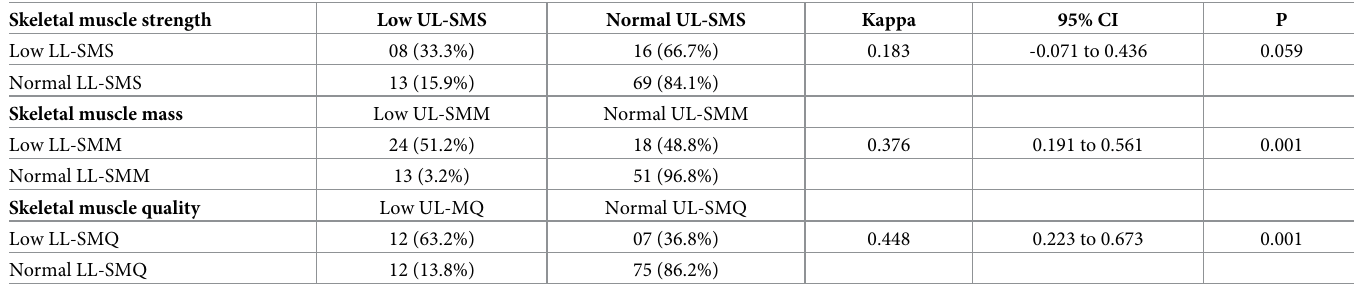
Table 4. Agreement between upper and lower limb measures to identify older males with low skeletal muscle strength, muscle mass and muscle quality. Skeletal muscle